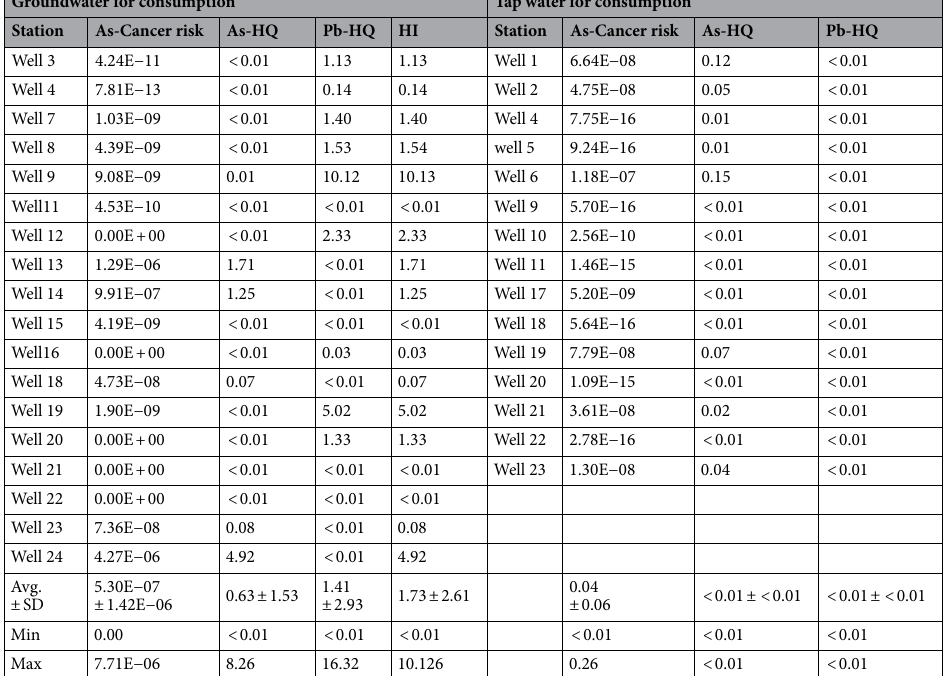
Table 2. Health risk assessment for the As and Pb levels in drinking water.